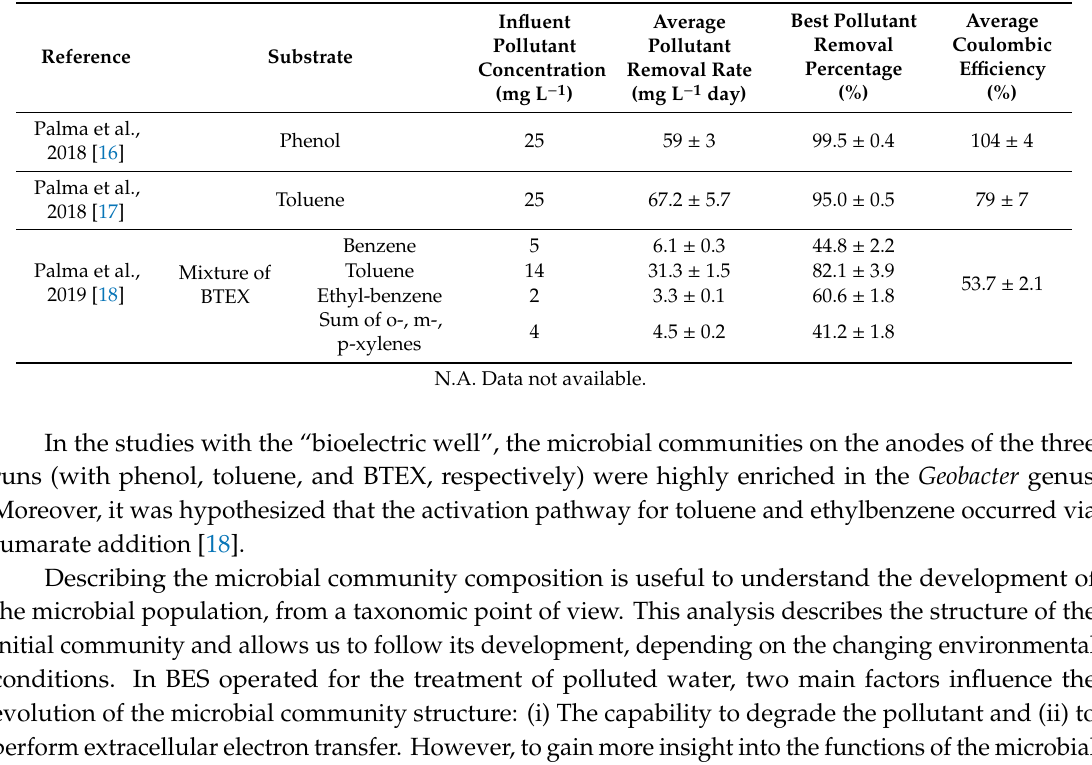
Table 1. Performances of the “bioelectric well” for the removal of aromatic compounds under optimal operating